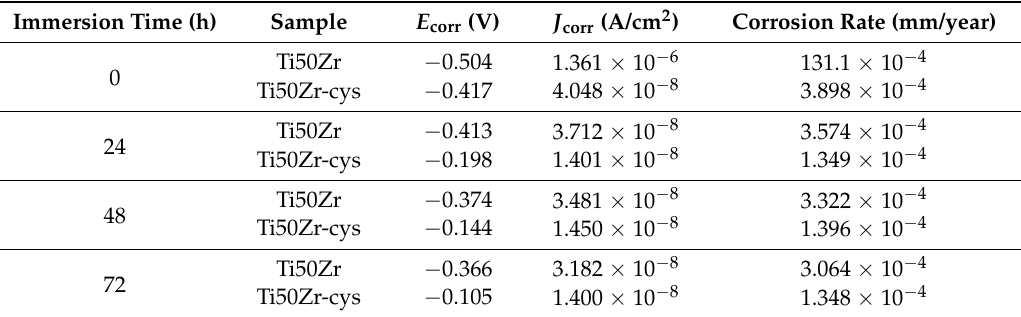
Figure 3. Tafel plots in time for Ti50Zr substrate and coated samples. Table 1. The electrochemical stability data obtained from Tafel plots. Table 1. The electrochemical stability data obtained from Tafel plots.